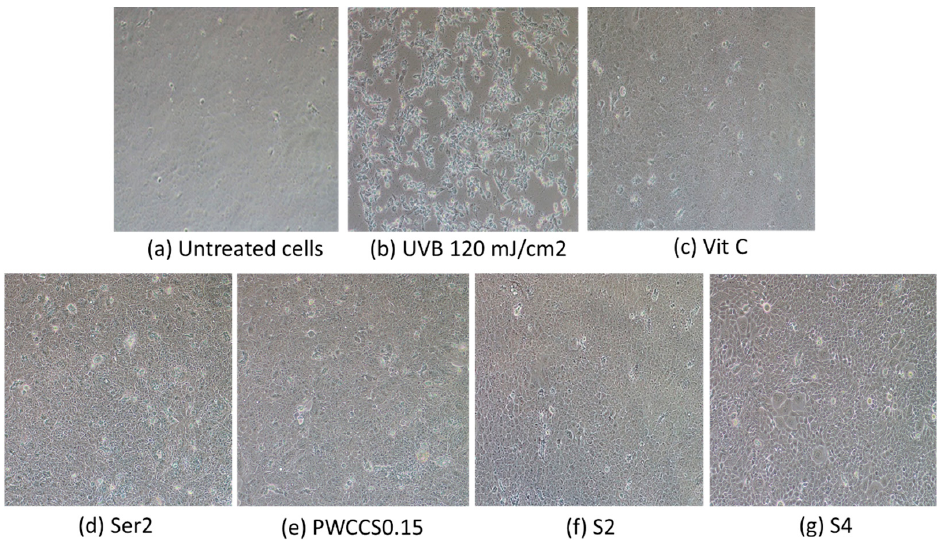
Figure 8. Morphology of the HaCaT cells pretreated with the hydrogels and components for 6 h before the UVB irradiation at 120 mJ/cm 2 : ( a ) untreated cells, ( b ) cells irradiated with 120 mJ/cm 2 , ( c ) cells treated with 25 µ g/mL ascorbic acid, ( d ) cells treated with 2% sericin (Ser2), ( e ) cells treated with 0.15% PWCCS (PWCCS0.15), ( f ) cells treated with S2, ( g ) cells treated with S4.